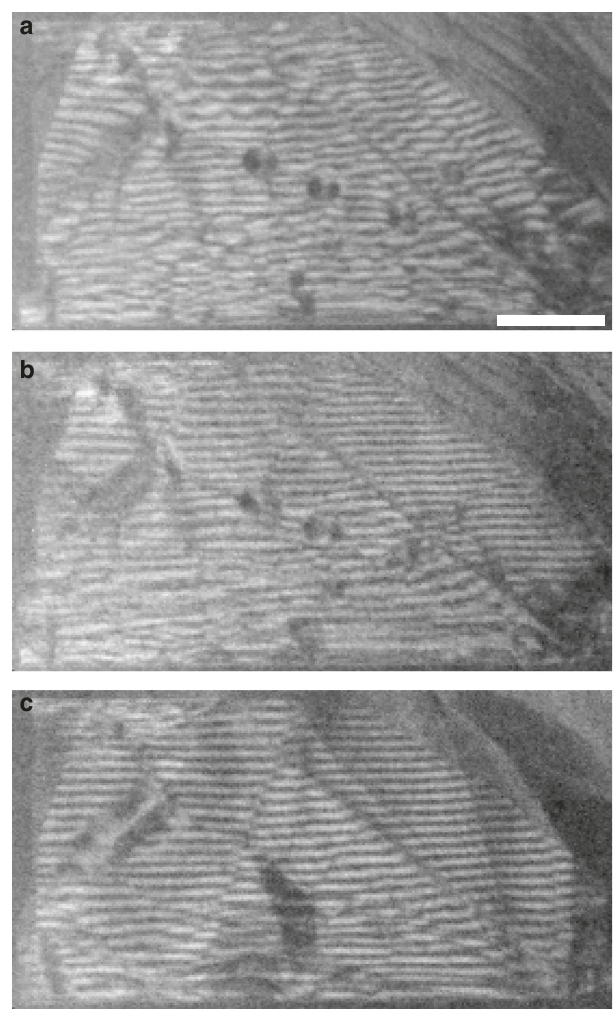
Fig. 4 Moiré pattern evolution during intercalation. Moiré pattern from a 10 nm-thick graphite fl ake folded onto itself: ( a ) pristine, ( b ) after the fi rst structural change and ( c ) after one complete intercalation/deintercalation cycle. See Supplementary Movie 3 for the complete evolution. The scale